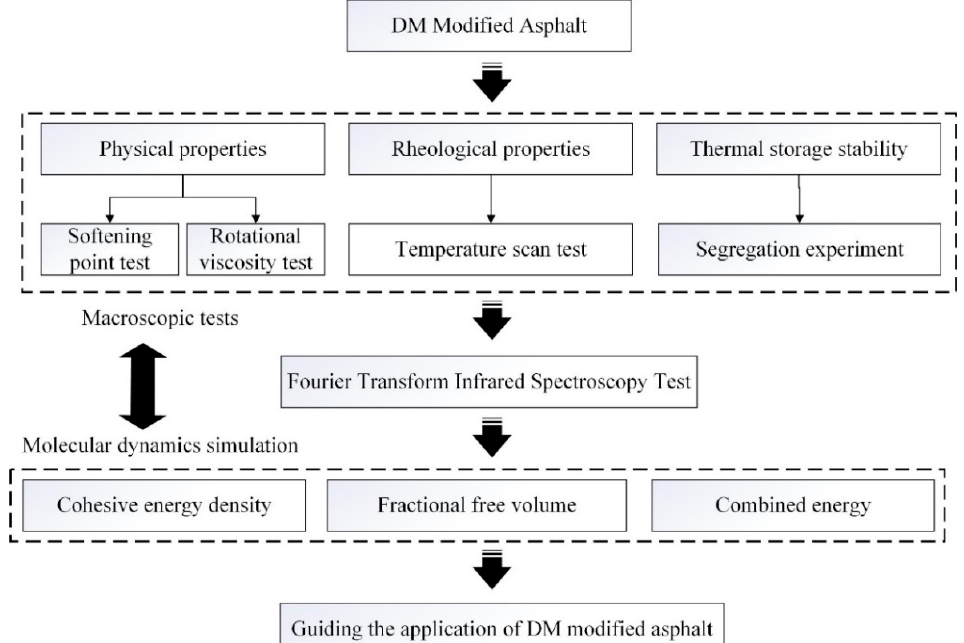
Figure 2. Flowchart of the experimental plan.